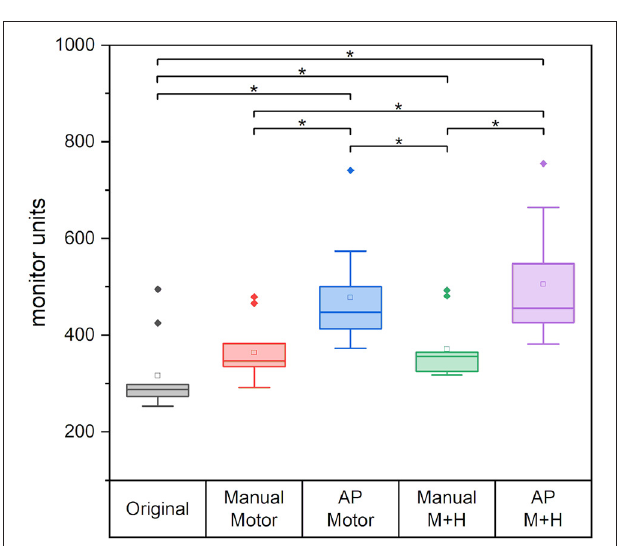
FIGURE 12 | The required monitor units for the different plans. Line = median value, square = mean value, diamond = outliers, star = statistically significant p <